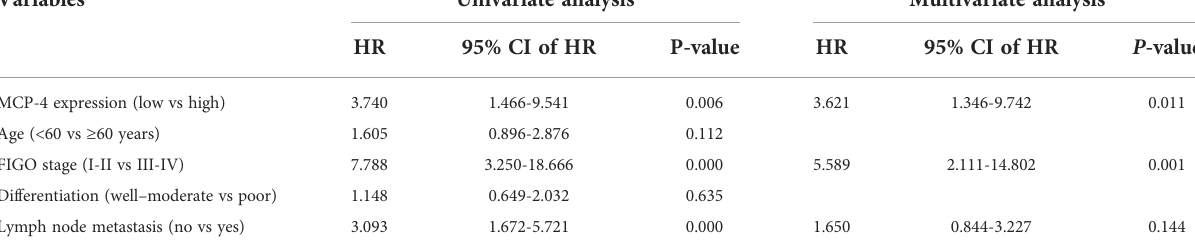
TABLE 3 Cox regression analysis of overall survival of ovarian epithelial malignant